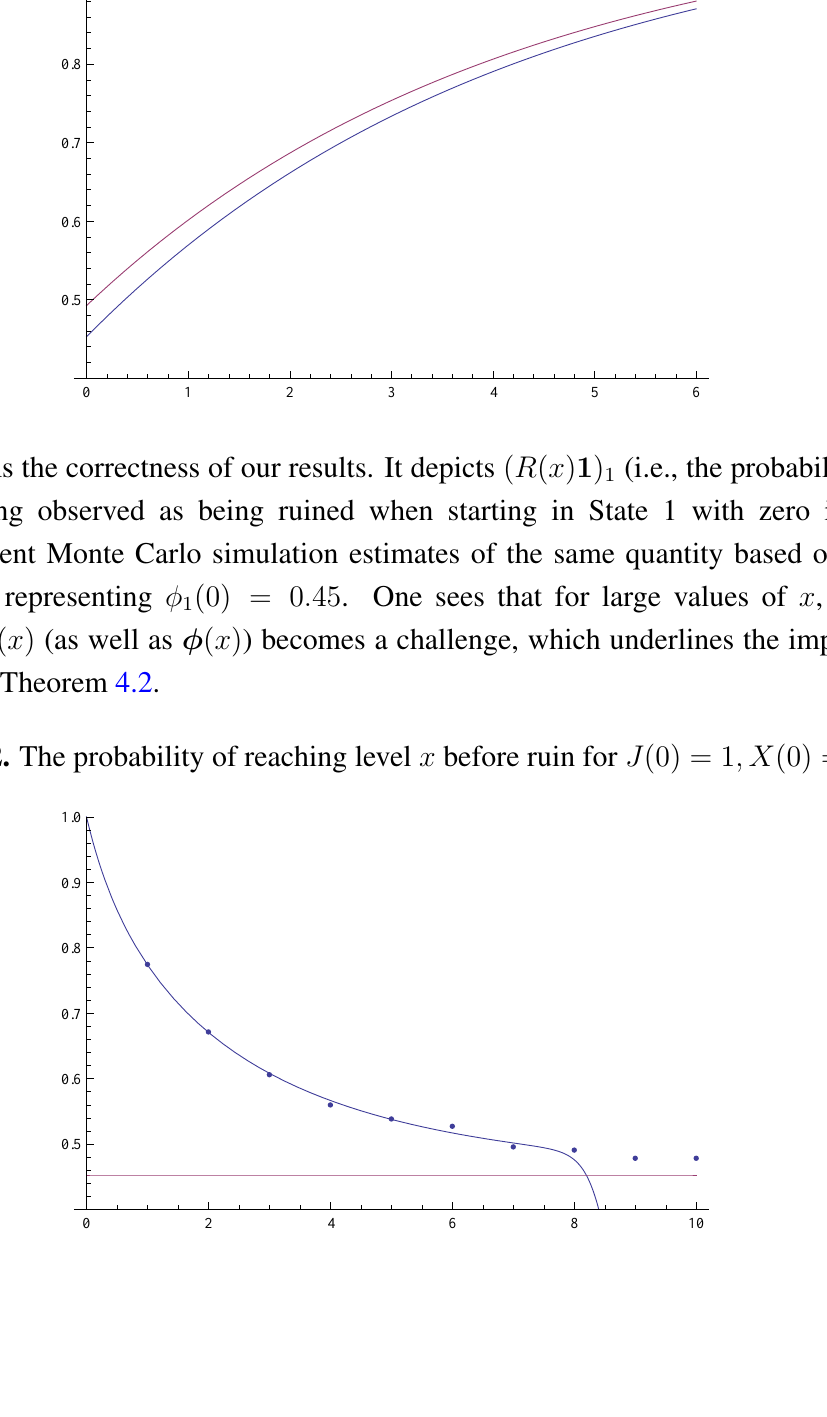
Figure 1. Survival probabilities, φ